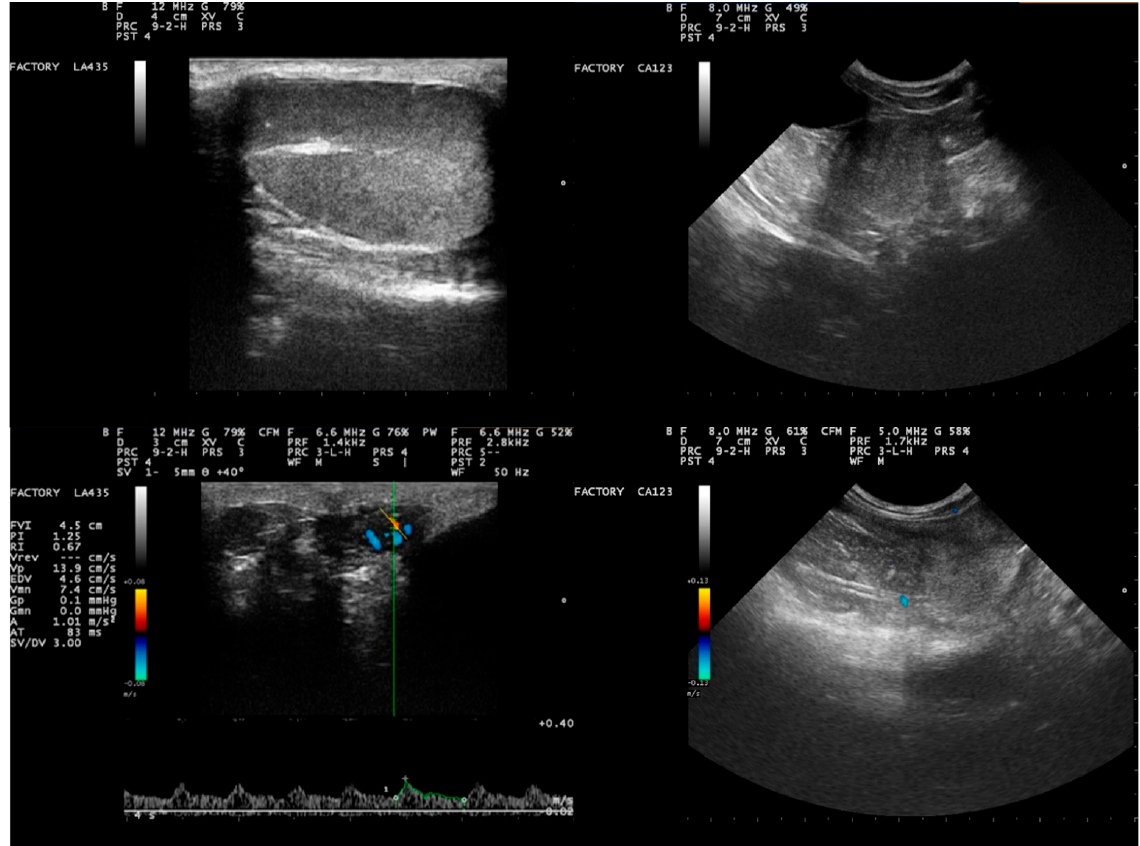
Figure 1. Results of ultrasonographic examination of the genital system of Beagle-breed dogs (clock- wise from top left): B-mode ultrasonographic image of testicular parenchyma (sagittal section; the testicular capsule and skin were evident as a distinct hyperechogenic line rounding the parenchyma, which appears homogeneous with a central hyperechogenic line representing the mediastinum testis), B-mode ultrasonographic image of prostate parenchyma (transverse section; the gland is imaged with a regular shape and homogeneous appearance, generally hypoechoic compared to adjacent fat), Color Doppler of the prostate (longitudinal section; a few separate branches of capsular vessels are obvious in the peripheral zone of the gland), Pulsed Wave Doppler image of the looping part of the supratesticular artery; hemodynamic parameters calculated by the equipment software as seen in the image, where a low resistive flow pattern can be observed with obvious peak systolic